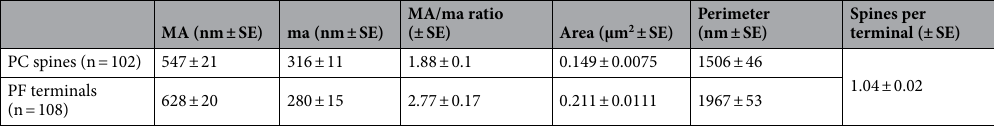
Table 2. Ultrastructural analysis of different morphological features of PC spines, and presynaptic terminals in the superficial outer layer (str. moleculare) of the cerebellar cortex. Major axis length (MA), minor axis length (ma), ratio (calculated, MA/ma), area, perimeter, and multi synaptic bouton density (spines per terminal).